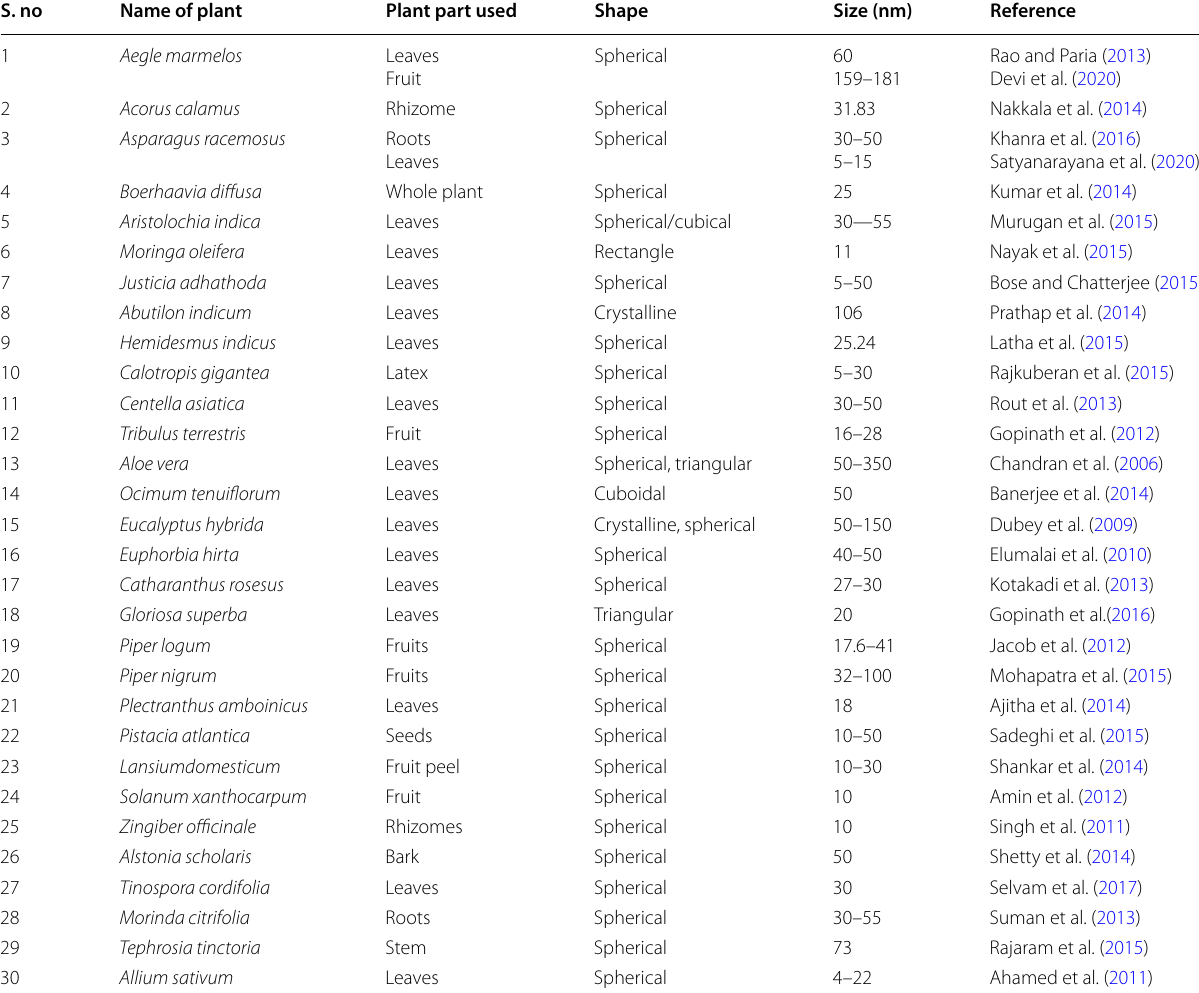
Table 1 Biosynthesis of AgNPs from different plants parts with its respective size and shape S.